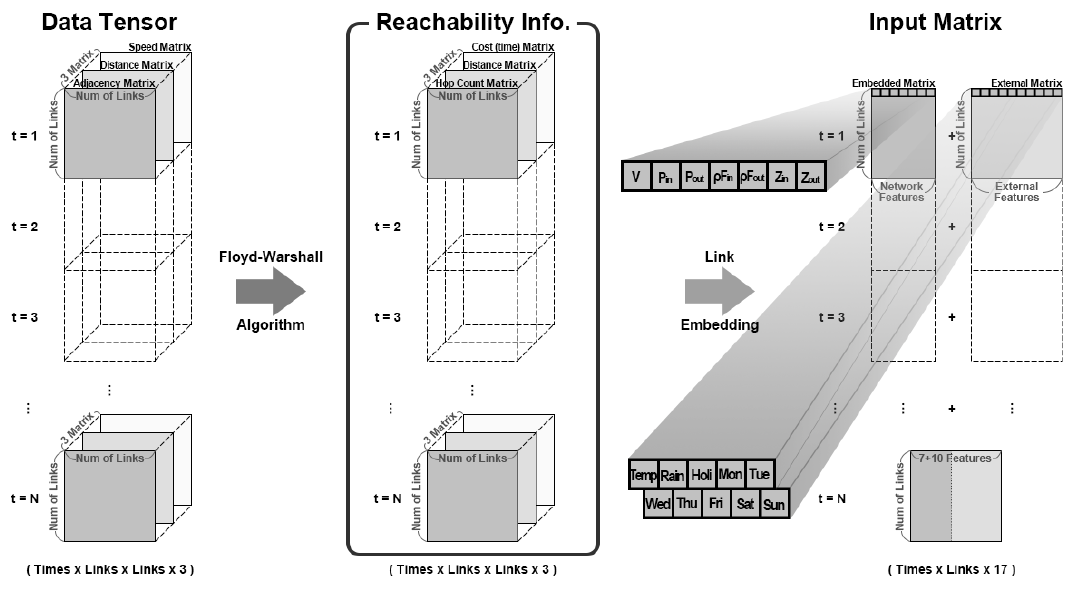
Figure 8. Generation of the input tensor reflecting the context-aware traffic flow centrality of every